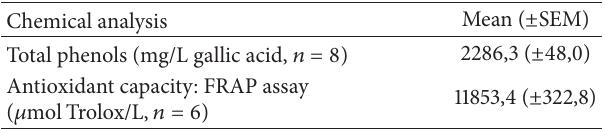
Table 5: Total phenolic content, antioxidant capacity of cinnamon tea. Values are mean ± SEM.